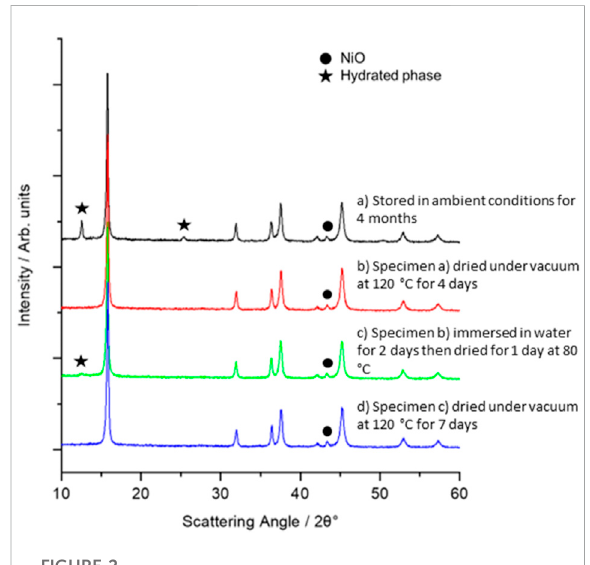
FIGURE 2 XRD data for P3-NNM after (A) storage in a cupboard for 4 months (black), (B) dried in a vacuum oven for 4 days at 120 ° C (red), (C) immersed in water for 2 days and dried for 1 day at 80 ° C (green), and (D) then fi nally dried in a vacuum oven for 7 days at 120 ° C (blue). Additional Bragg re fl ections from secondary phases are indicated using a fi lled circle (NiO) or star (hydrated phase)